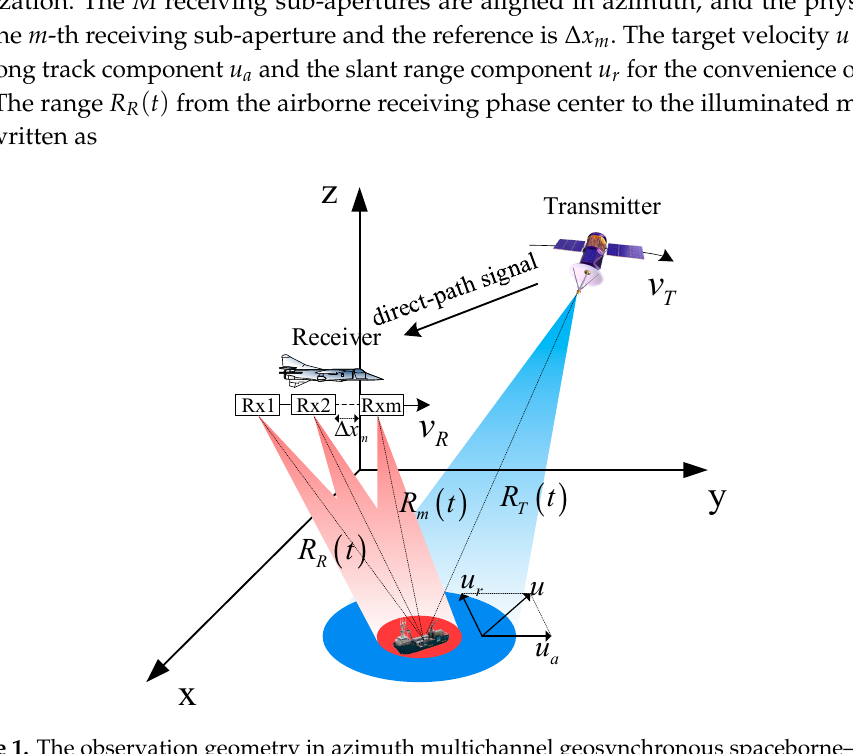
Figure 1. The observation geometry in azimuth multichannel geosynchronous spaceborne–airborne bistatic synthetic aperture radar (GEO-SA-BiSAR).